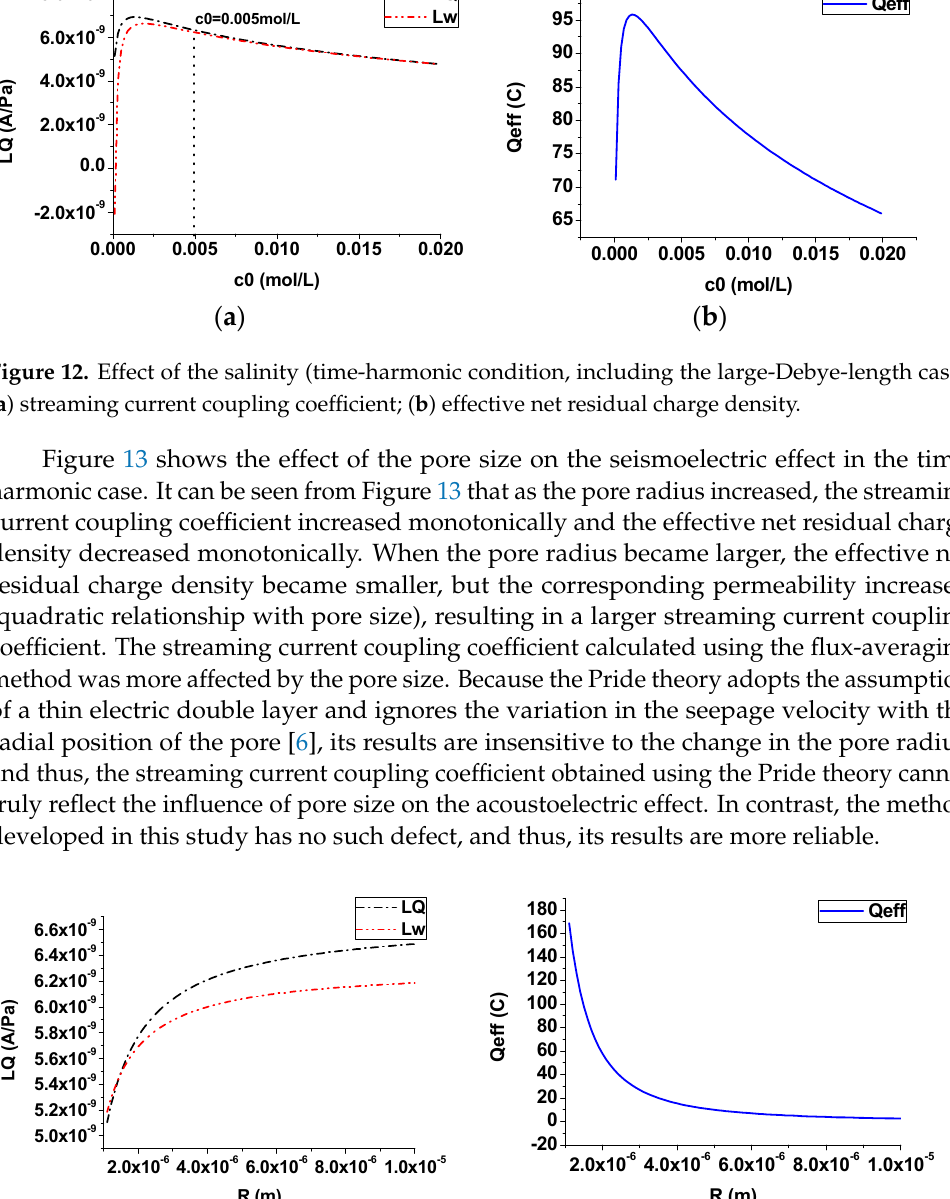
Figure 11. Effect of the salinity (time-harmonic case): ( a ) streaming current coupling coefficient; ( b ) effective net residual charge density.